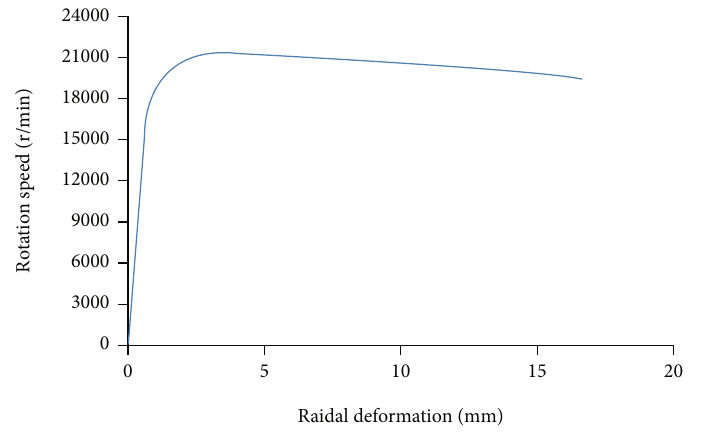
Figure 14: Rotational speed versus radial deformation.